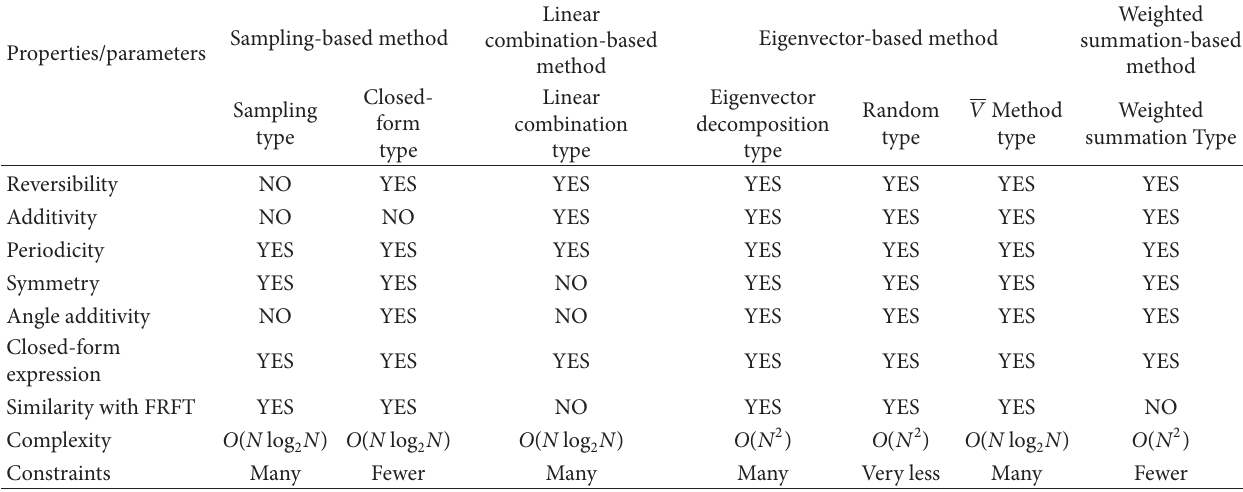
Table 1: Comparison of Different Types of DFRFT